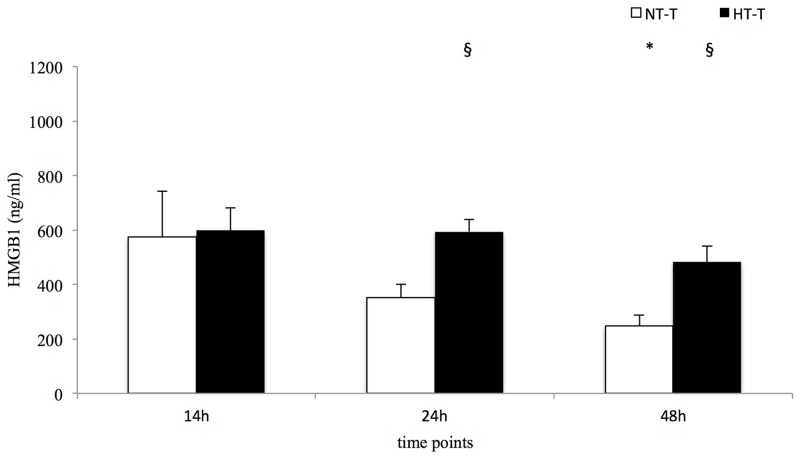
Local HMBG1 concentrations.Statistical significance p = <0.05 (* from baseline, § NT-T vs. HT-T).